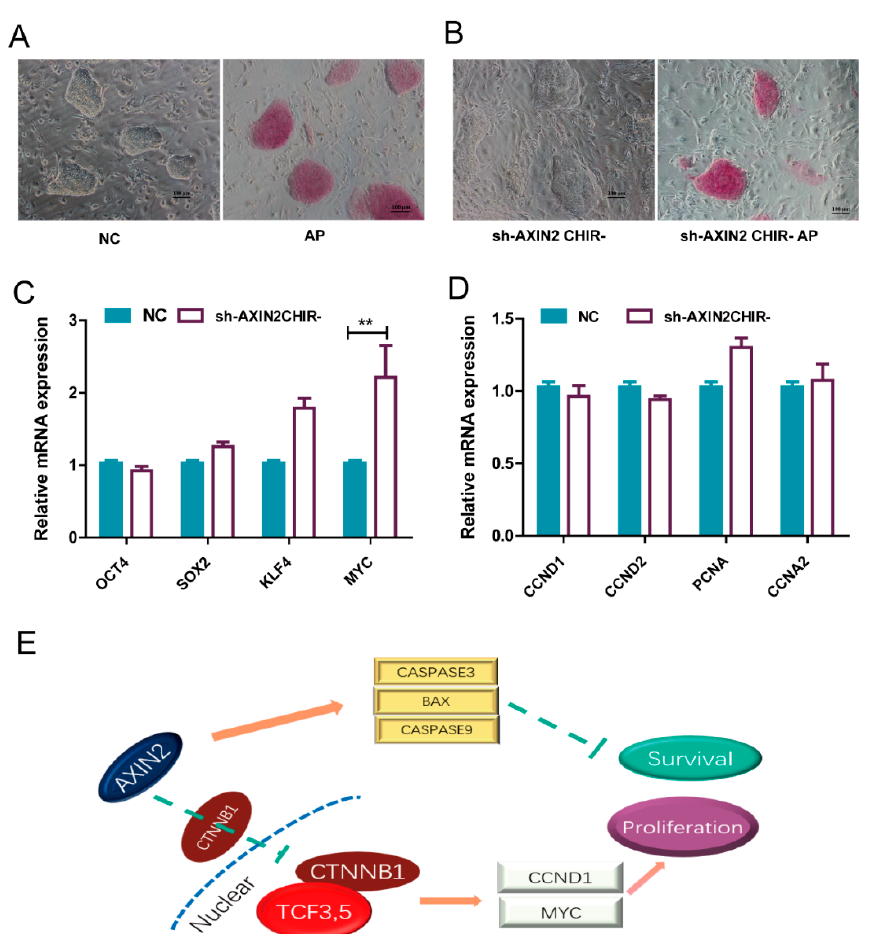
Figure 6. sh-AXIN2 could maintain the proliferation and pluripotency of piPSCs without CHIR99021. ( A ) Representative image of bright field and AP staining in the NC group with CHIR99021; the scale bar represents 100 µ m; ( B ) representative image of bright field and AP staining in sh-AXIN2 group withdout CHIR99021; the scale bar represents 100 μ m; ( C ) qPCR analysis of endogenous OCT4 , SOX2 , KLF4 , and MYC in NC, sh-AXIN2CHIR- groups; ** represents p < 0.001; ( D ) qPCR analysis CCND1, CCND2, PCNA , and CCNA2 in NC, sh-AXIN2CHIR- groups; ( E ) diagram of the function of AXIN2 in piPSCs; The arrow in the color of brown means promotion, and in the color of green means suppression.